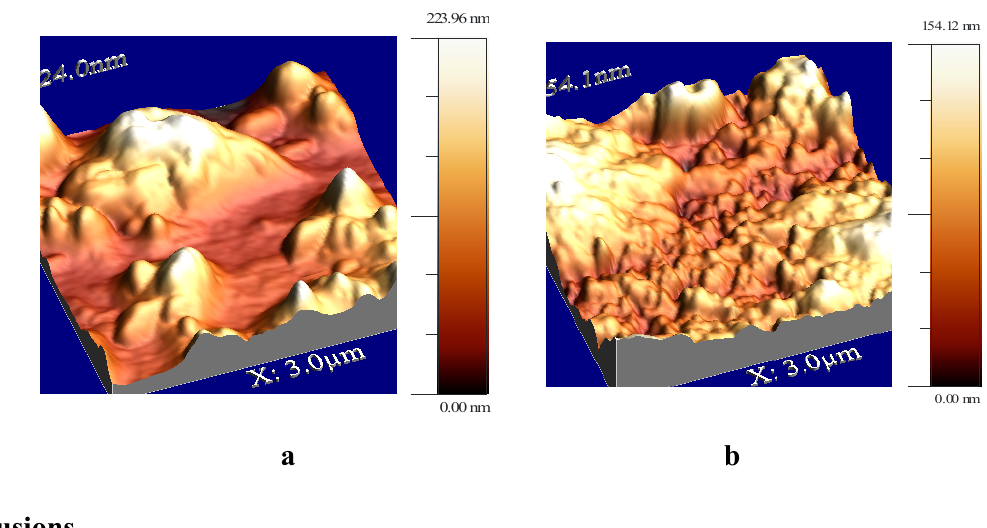
Figure 14. AFM images of stearic acid/ 4 /laccase- a and stearic acid/ 4 /tyrosinase LB film- b . All images are 3 µm × 3 µm